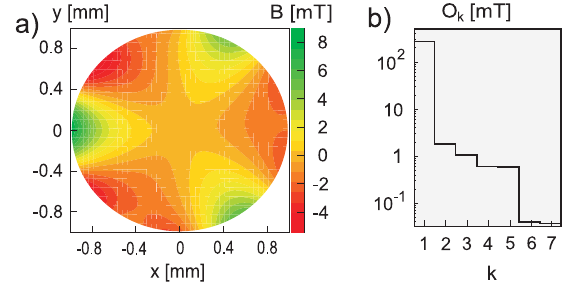
FIG. 4. (Color) Part (a) shows the azimuthal HOMFC from P ~B ¼ 6 ½ B ð (cid:1); ’ Þ ~e þ B ð (cid:1); ’ Þ ~e (cid:3) , note the absolute Fig. 3 ( l(cid:1) (cid:1) l’ ’ l ¼ 3